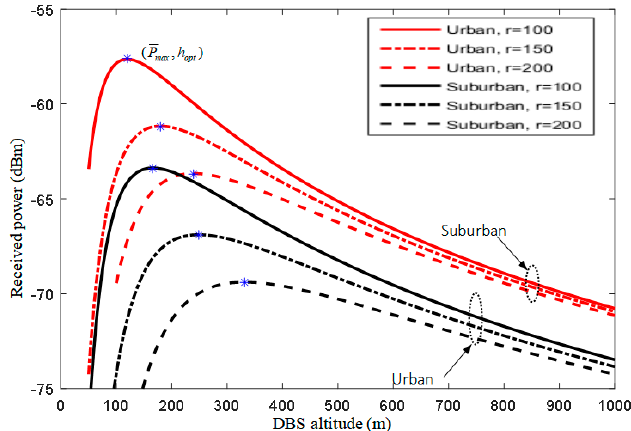
Figure 4. Received power vs. optimal DBS altitude under different on-demand coverage radius.